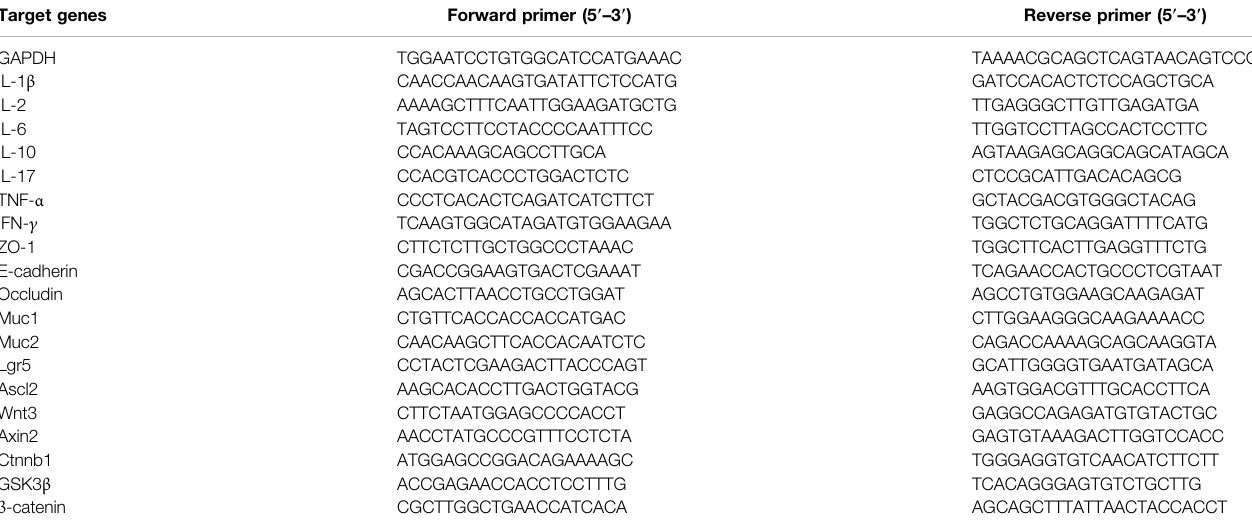
TABLE 1 | Primer Sequences Used for